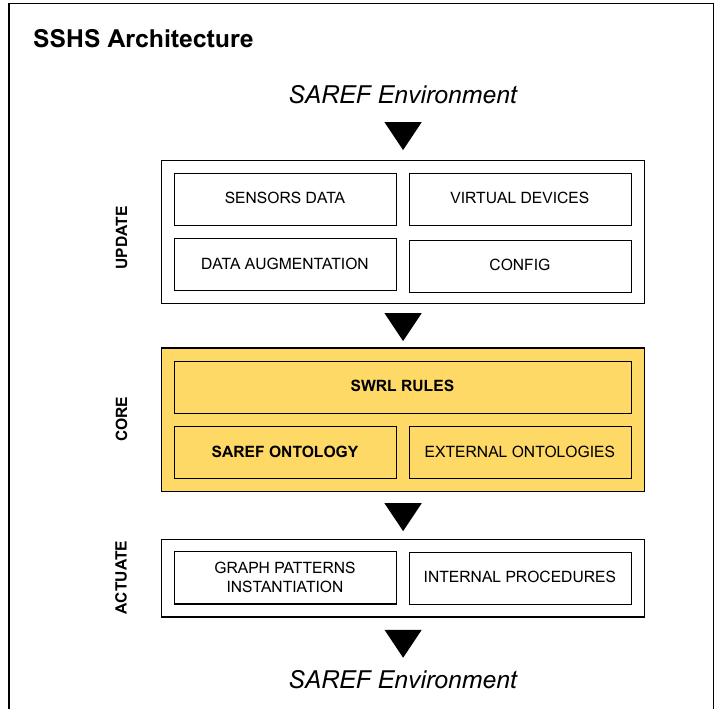
Figure 2. The Semantic Smart Home System architecture. The system is made up of three main components: the update component which collects data from the SAREF environment and constructs the RDF graph representing the current house status, the core component in that executes the SWRL rules over the content of the main graph, and the actuate component which inspects the reasoning result and sends commands back to the actuators. These tasks are executed sequentially in a